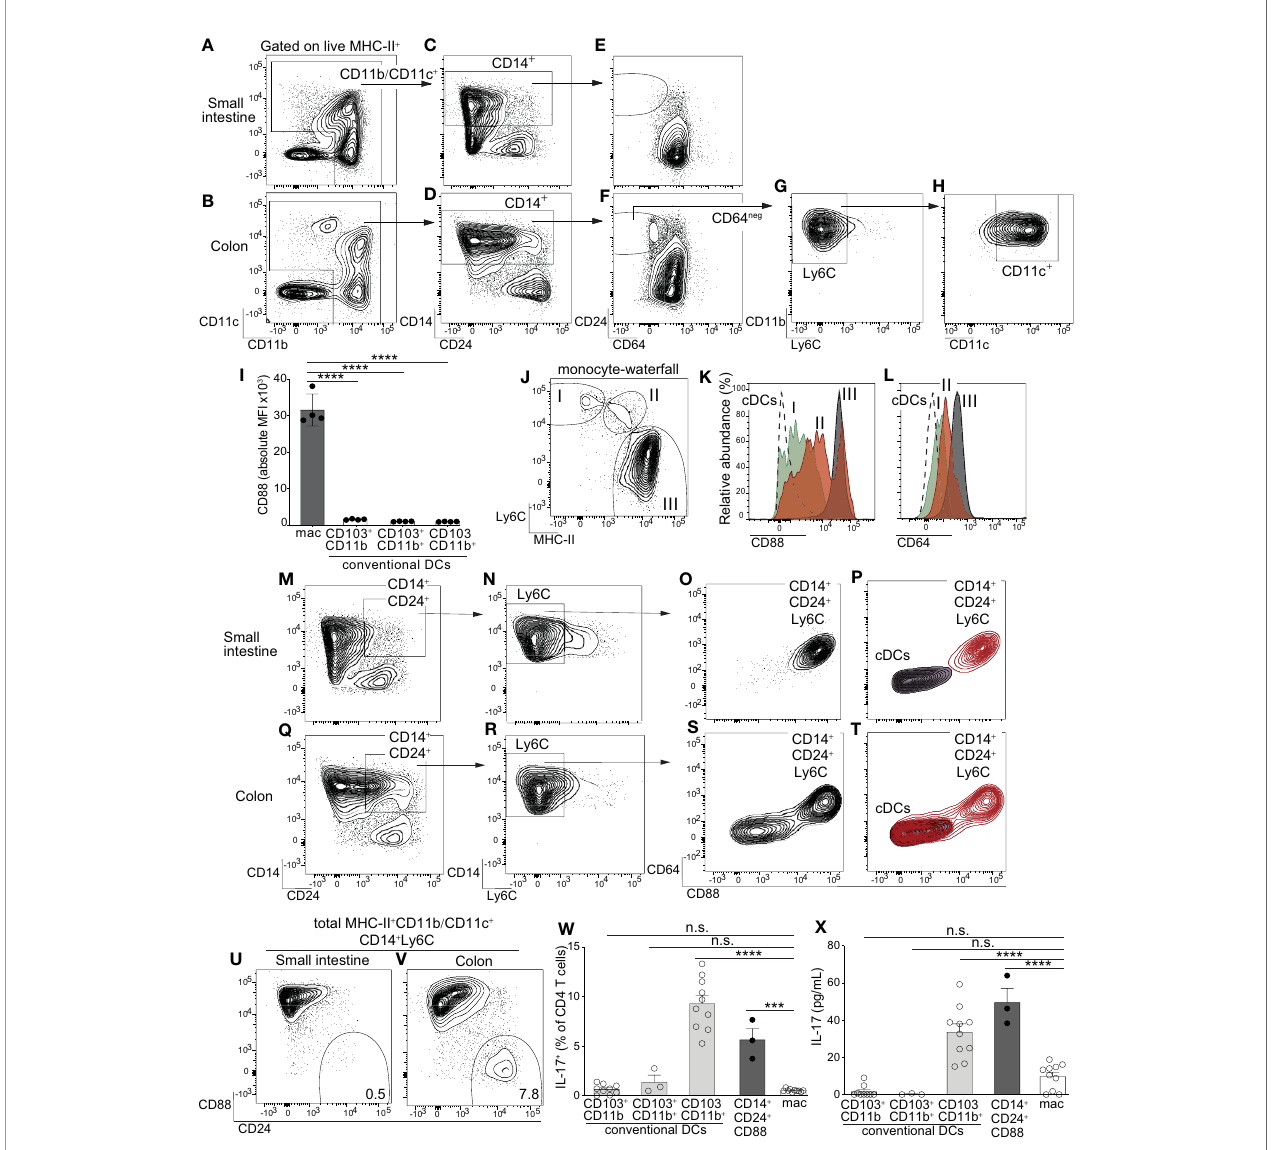
FIGURE 1 | Identi fi cation of a novel population of CD14 + CD24 + CD88 – mononuclear phagocytes that reside in colon and are exclusive to this intestinal organ. Representative plot gated on live MHC-II + APCs from small intestine lamina propria (SI-LP) (A) or colon lamina propria (C-LP) (B) . (C, D) CD11b/CD11c + APCs from SI-LP (C) gated in (A) or C-LP (D) , gated in (B) evaluated for CD14 and CD24 expression. (E, F) CD14 + populations from SI-LP (E) gated in (C) or C-LP (F) gated in (D) evaluated for CD24 and CD64 expression. (G) The CD64 negative population from C-LP [gated in (F) ] evaluated for Ly6C expression. (H) The Ly6C – population gated in (G) evaluated for CD11b and CD11c expression. (I) Mean fl uorescence intensity (MFI) of surface CD88 expressed by SI-LP macrophages and each of the three cDC subsets (See Figure S1 for macrophage and cDC gating strategy). Each dot represents one mouse. (J) Representative plot gated on total CD11b + CD24 – cells from SI-LP depicting populations representing the developmental transition of monocytes into intestinal macrophages (termed the monocyte-waterfall): (I) Ly6C + MHC-II – monocytes; (II) Ly6C + MHCII + transitioning monocytes; (III) Ly6C – MHCII + mature macrophages. (K, L) Gated populations shown in (J) and total cDCs were evaluated for CD88 (K) and CD64 expression (L) : Dashed line, cDCs; (I) Green, monocytes; (II) Red, transitioning monocytes; (III) Gray, mature macrophages. (M) SI-LP APCs gated as in (A) were evaluated for CD14 and CD24. (N) CD14 + CD24 + populations gated in (M) were evaluated for Ly6C. (O) Ly6C – populations gated in (N) were evaluated for CD64 and CD88. (P) Contour plot overlay of SI-LP CD14 + CD24 + Ly6C – populations (red, gated in (N) ) and SI-LP cDCs (grey). (Q – T) C-LP APCs were gated and analyzed as in (M – P) . (U – V) Representative plots of total live MHC-II + CD11b/CD11c + CD14 + Ly6C – APCs from SI-LP (U) or C-LP (V) evaluated for CD88 and CD24 expression (See Figure S3 for gating strategy). (W, X) C-LP mononuclear phagocytes of the indicated subset were co- cultured 1:1 with naïve OT-II CD4 T cells for 4 days. (W) T cells from each co-culture were restimulated and evaluated for the percentage of IL-17 + OT-II T cells. (X) The abundance of IL-17 protein in co-culture supernatant prior to stimulation was analyzed in parallel. Data in (W, X) is combined from three independent experiments each containing sorted APCs from at least 5 mice. Each dot represents one experiment or replicates within an experiment. Error bar represents mean ± SEM. Data in (A – V) is representative of >40 individual mice. *** p < 0.001, **** p < 0.0001, n.s., not signi fi cant (one-way ANOVA with Tukey ’ s post hoc